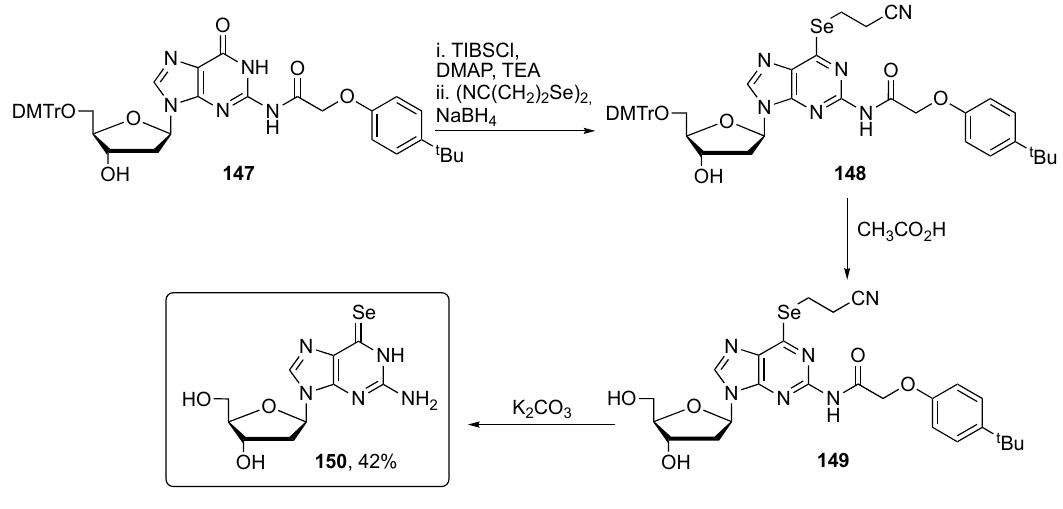
Scheme 25. Synthetic pathway to obtain